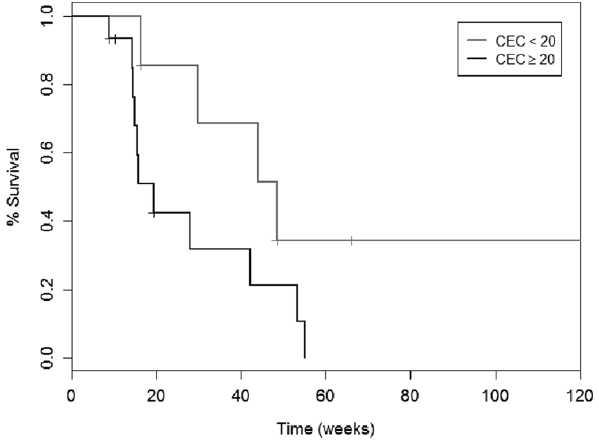
Figure 2. Kaplan-Meyer analysis of survival. Overall survival curve according to pretreatment CECs values were dichotomized as greater than 99% confidence interval in controls (CEC=20 cells/ml) (Log rank=4.566; p=0.033). CECs: circulating endothelial cells.